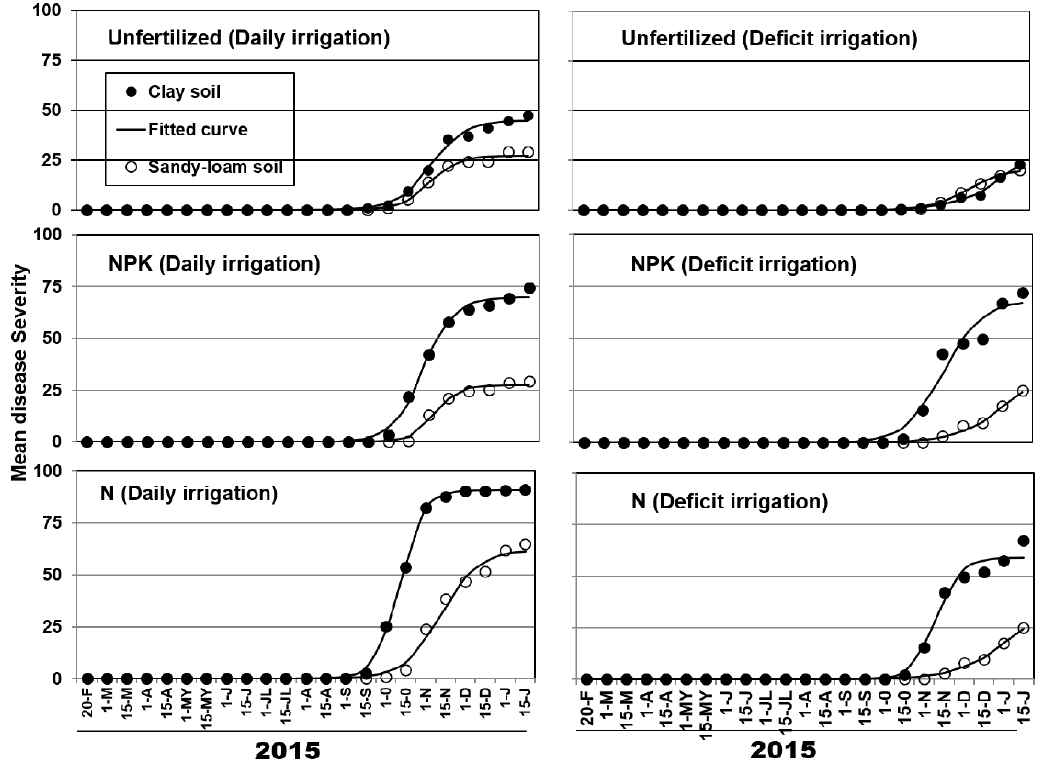
Figure 2. Progress of mean severity of symptoms of Verticillium wilt in Picual cultivar olive plants grown in microplots of a clay and sandy-loam soils (for more details see Materials and methods section) naturally infested with Verticillium dahliae and subjected to a combination of two irrigation frequencies: daily and deficit, and three nitrogen fertilization treatments: control without fertilization (Unfertilized), fertilization with N-P-K (15%-15%-15%) (NPK) and fertilization with Calcium Nitrate (15.5%-0-0) (N). Disease severity was estimated on a 0 to 16 rating scale. This scale estimated the percentage of affected tissue using four main categories or quarters ( ≤ 25, 26–50, 51–75, and 76–100%) with four values per category. Thus, each scale value represents the number of sixteenths of affected plant area. The scale values (X) are linearly related to the percentage of affected tissue (Y) by the equation Y = 6.25X − 3.125 [30]. Symbols correspond to the observed mean severity data and lines are the estimated logistic curves.